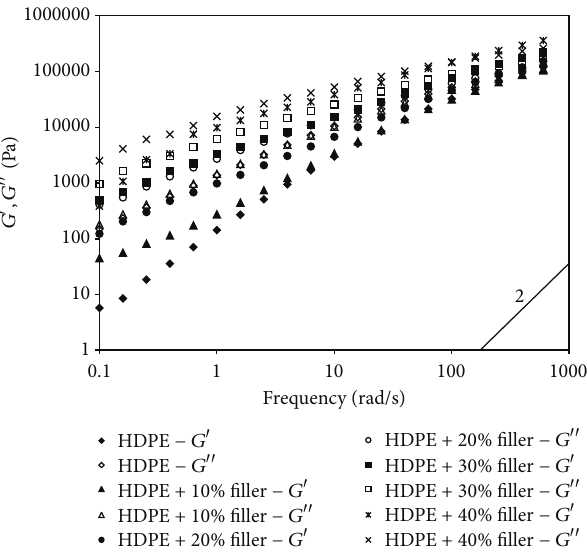
Figure 3: Variation of the storage modulus, 𝐺 󸀠 , and loss modulus, 𝐺 󸀠󸀠 , as a function of frequency for neat renewable HDPE and its composites containing different wt% of sponge gourd